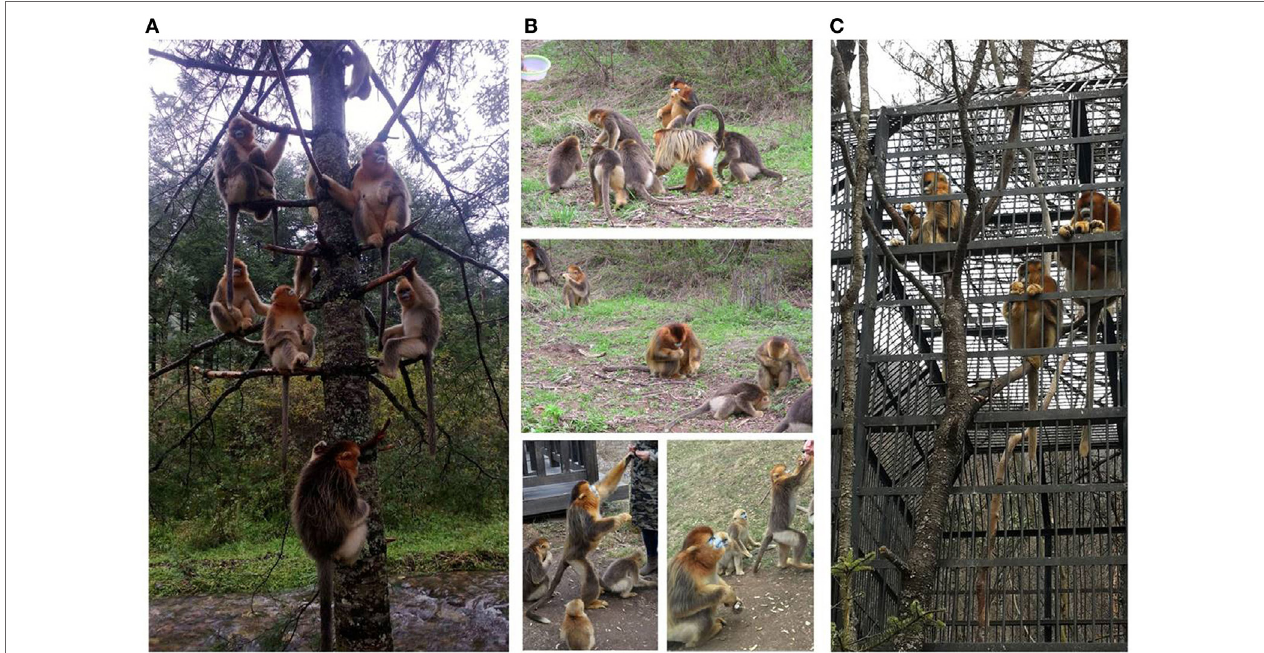
FigUre 1 | Monkeys sampled in this study. (a) The monkeys from a one-male and multi-female unit waiting for food in the tree before feeding time; (B) monkeys fed with different food, which varies with the seasons; (c) the monkeys kept in the cage which is located in an open area.